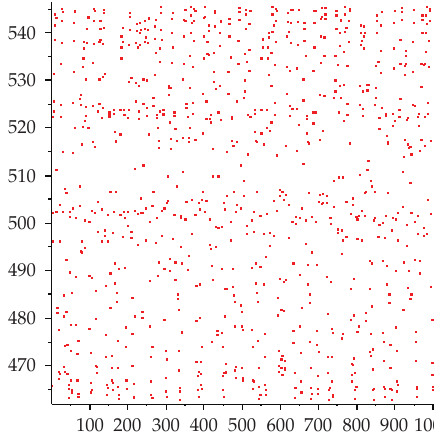
Figure 10: (cid:2) t,y (cid:2) t (cid:3)(cid:3) in the deterministic case for d (cid:7) 0 . 8.